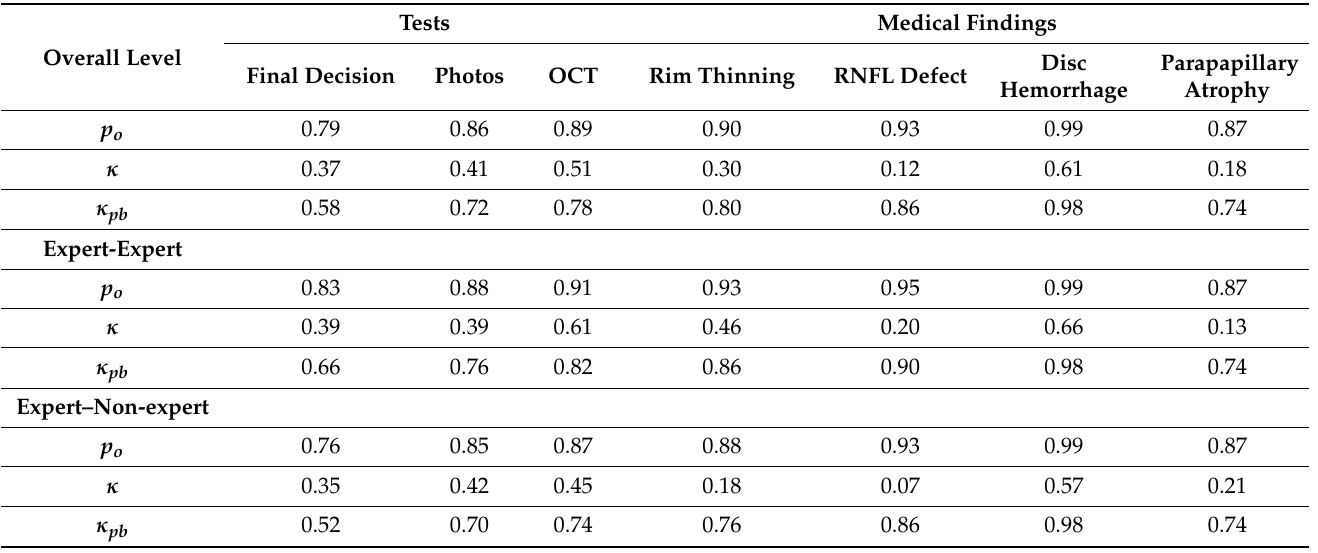
Table 2. Agreement in test evaluation and medical findings (overall and by